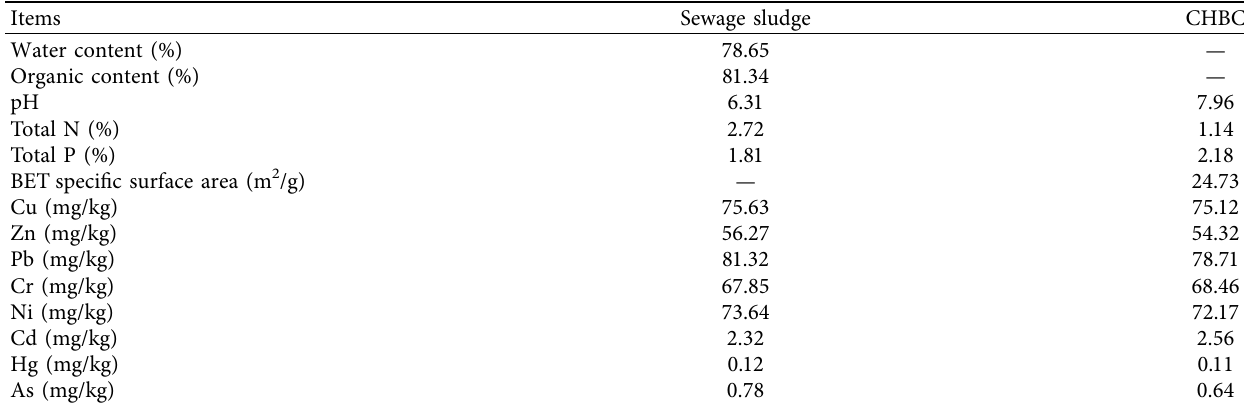
Table 2: Physicochemical properties of sewage sludge and CHBC.